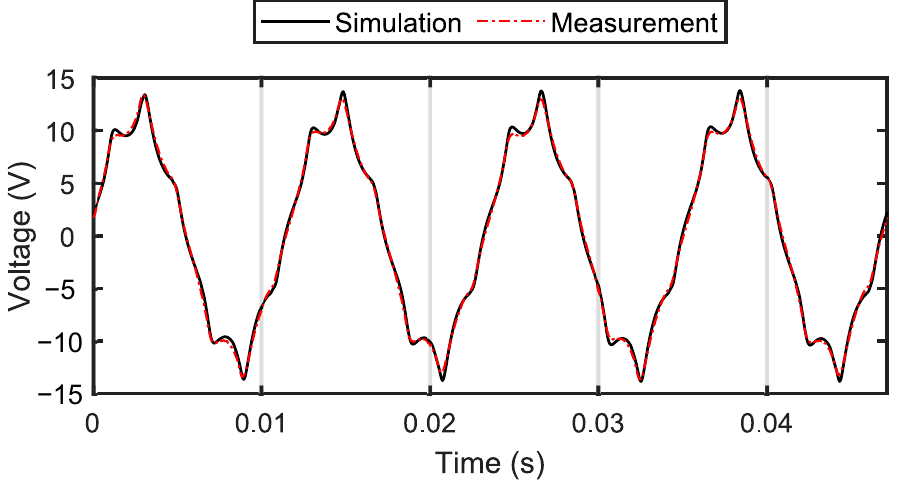
Figure 11. Induced line voltage feeding a 3.3 Ω